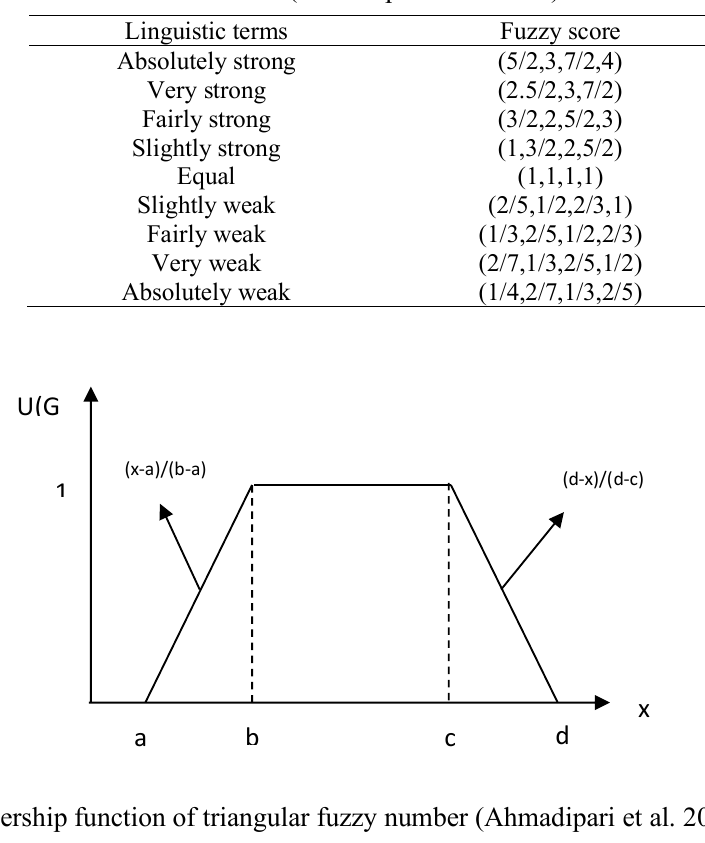
Table 2. Fuzzy assessment scale in FAHP (Ahmadipari et al. 2018)